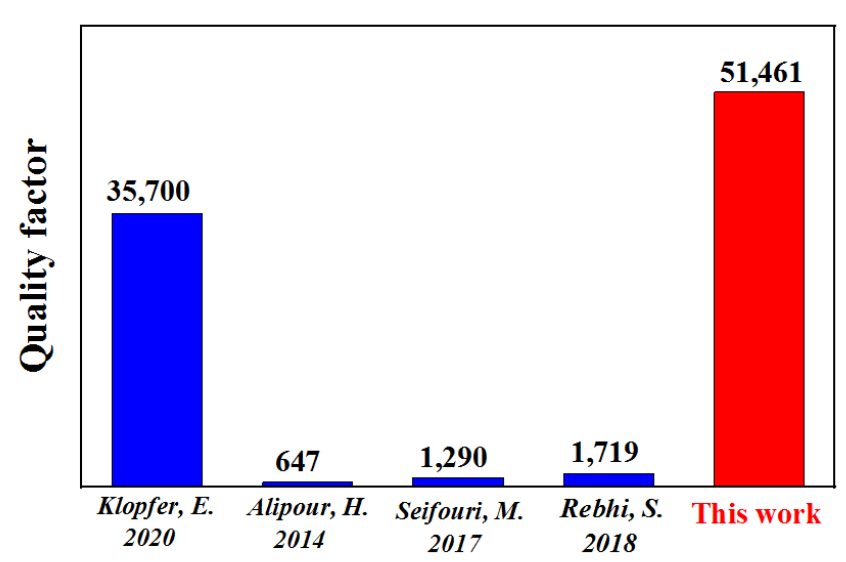
Figure 7. Comparison of quality factors amongst different structures. (Klopfer, E. 2020 [45]; Alipour-